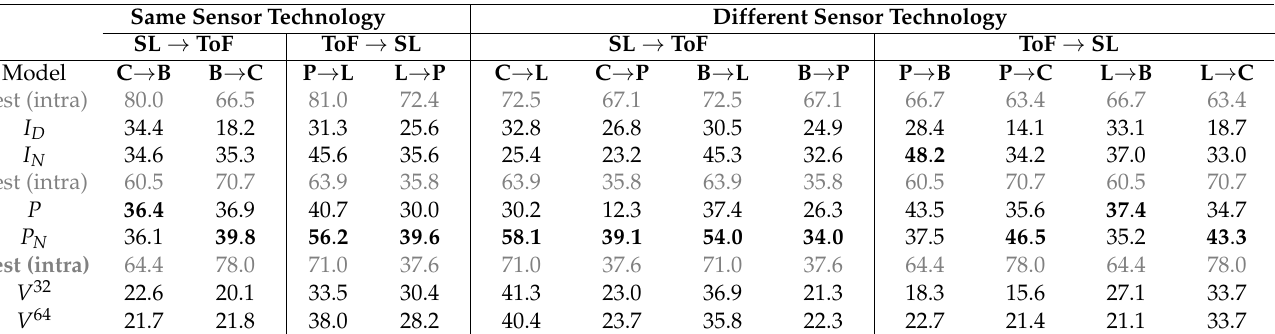
Table 6. Cross-dataset results, in terms of recognition accuracy. The data type used in input is reported ( I D : Depth Maps, V : Voxels, P : Point Clouds), together to each dataset (C: Curtinfaces [28], B: Biwi [22], L: Lock3DFace [21], P: Pandora [14]), and each technology of depth sensors (SL: Structured Light , ToF: Time-of-Flight ). D 1 → D 2 means “trained on D 1 and tested on D 2